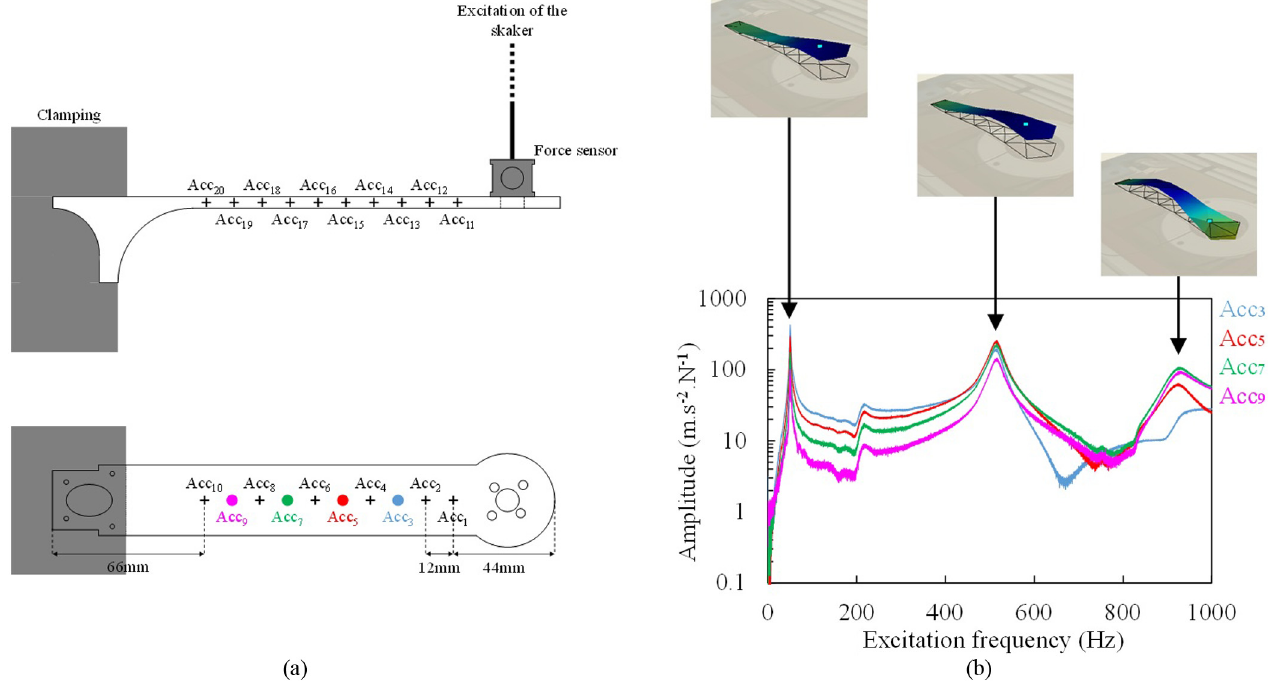
Fig. 4. (a) Set up use to characterize the arms and localization of the different accelerometers on the revised arm. (b) Identi fi cation of the fi rst three “ out-of-plane ” bending modes of the initial arm. Frequency Response Function (FRF) measured by injecting a white noise at the free end of the initial